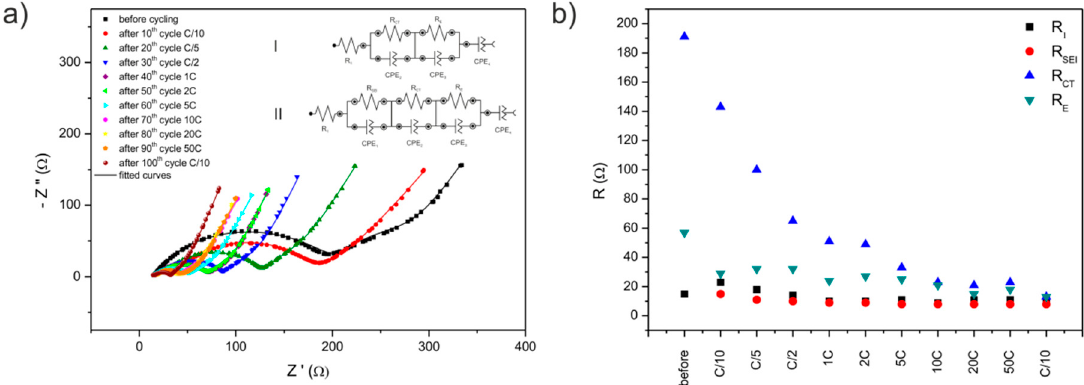
Figure 7. Nyquist plots for Li/Li + /LiMn 1.9 Ni 0.1 O 3.99 S 0.01 cell with the equivalent circuits used to model ( a ) the EIS (electrochemical impedance spectroscopy) spectra; and ( b ) the changes of EIS parameters. Table 3. Parameters of EIS measurements (calculated values of resistors in proposed equivalent circuits) for LMN1OS electrode.